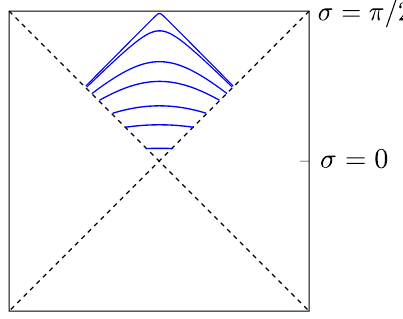
Figure 8 . The extremal surfaces which connect a piece of one horizon to the same piece of the other horizon. They cease to exist past σ = π/ 4 , before which a transition to the disconnected surface which sits on the two horizons occurs; this is like the Hartman-Maldacena transition in AdS/CFT. The area of this saddle diverges as σ → π/ 4 for all dS interval on each horizon the length of this saddle approaches a single horizon length 2 π